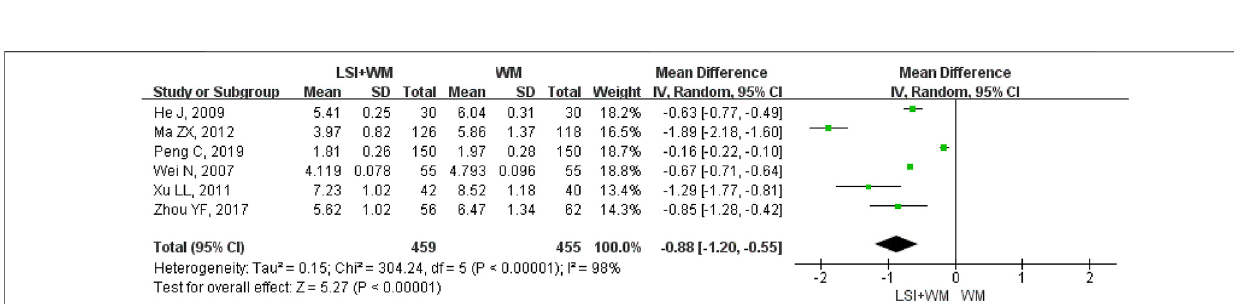
Frontiers in Pharmacology |